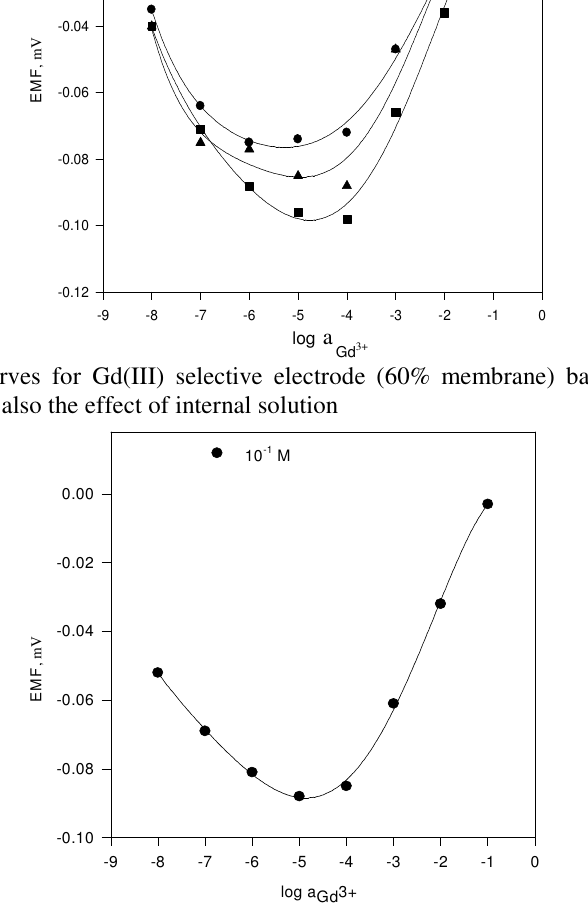
Figure 1 (d). Calibration curve for Gd(III) ion selective electrode based on ZrWP. Effect of